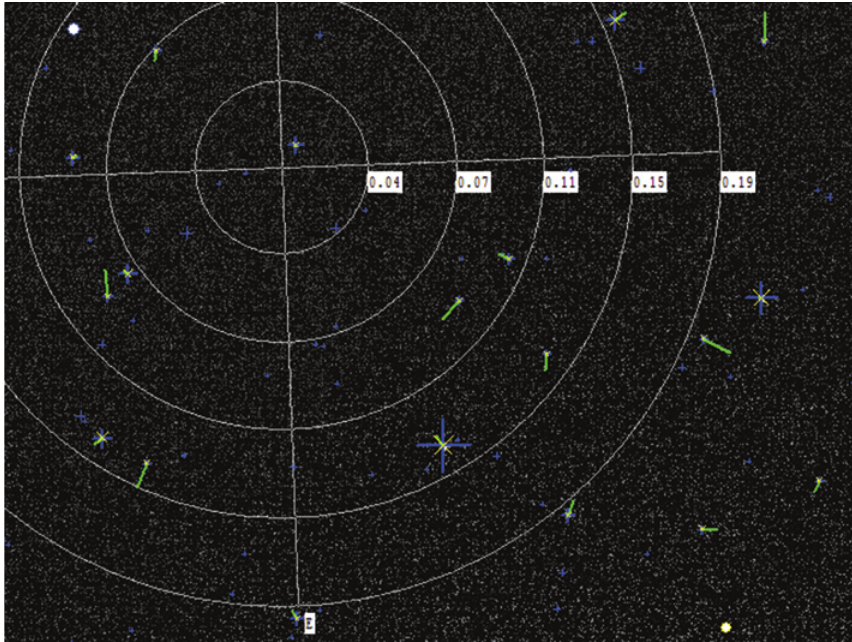
Fig. 5. Processed image of zenith area. Catalog stars (up to 13m) are shown by vertical marks, image prototypes - by sloped marks, green lines represent approximation